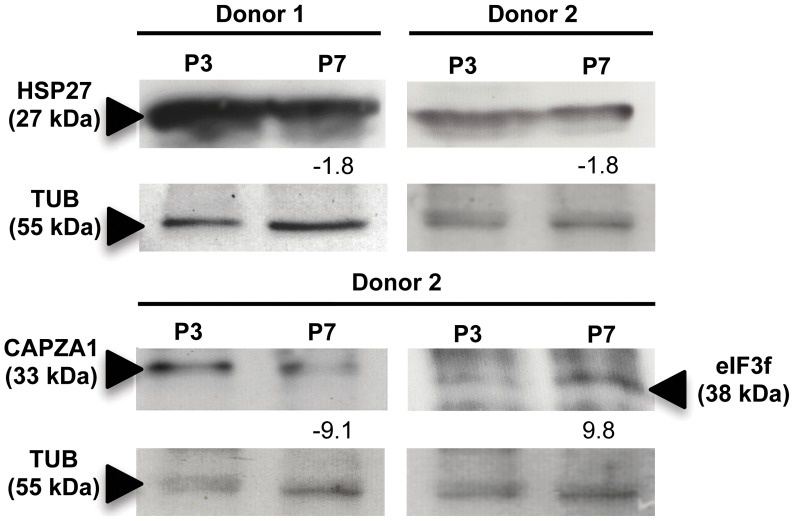
Validation of the changes in protein content of passage 7 (P7) and passage 3 (P3) cells that emerged from the quantitative proteomic analysis performed, also using cells from an additional Donor 2.Quantitative immunodetection of HSP27 (27 kDa) in Donors 1 and 2 showed a decreased content in P7 compared to P3 (upper panel). CAPZA1 (33 kDa) and eIF3f (38 kDa) exhibited decreased or increased levels, respectively, in P7 cells compared to P3, in Donor 2 (lower panel). All these results are consistent with the indications from 2-DE expression levels obtained for Donor 1. The values shown are the fold changes in P7 vs. P3, as measured by densitometry and normalized using the TUB (55 kDa) levels as the internal control.